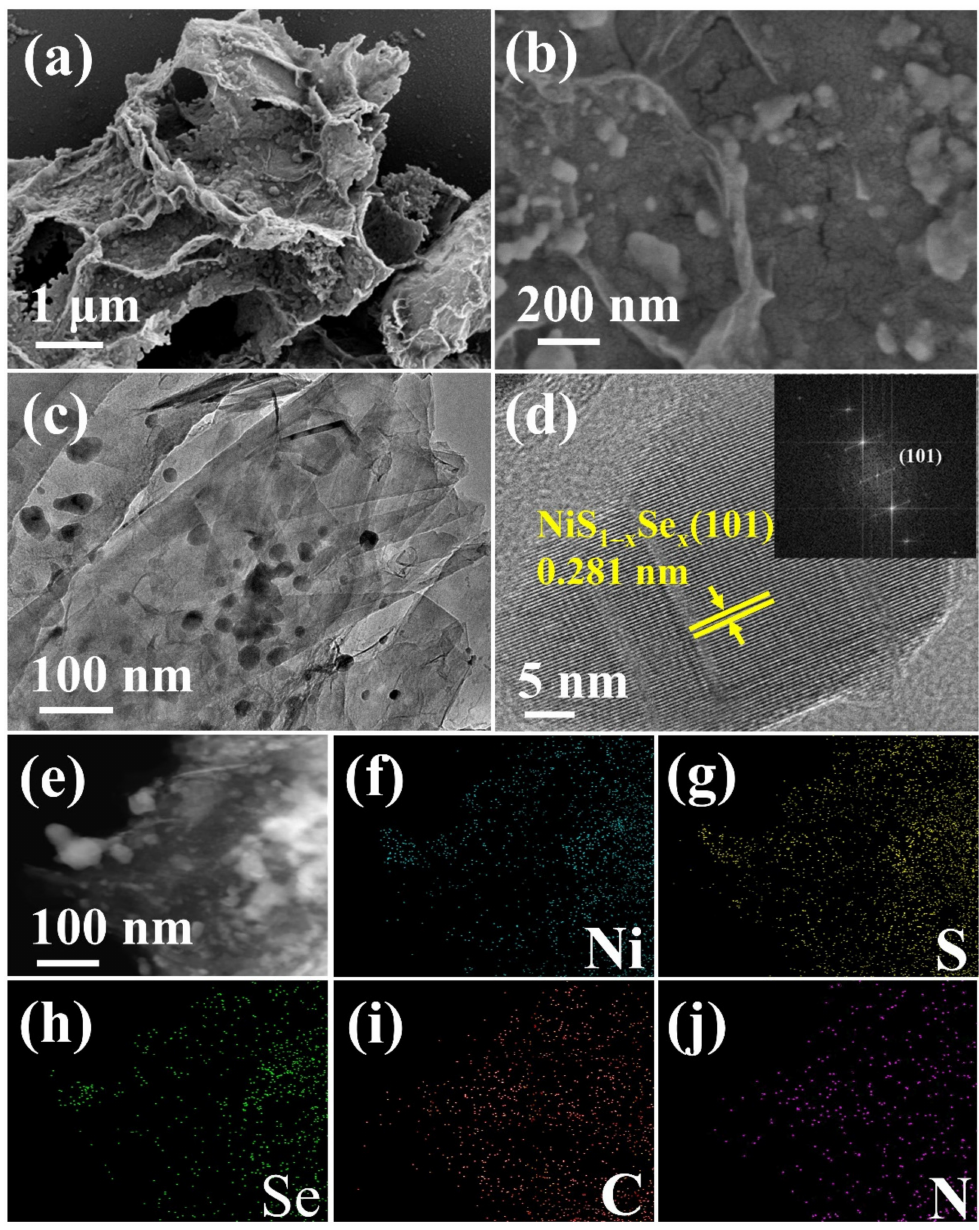
Figure 2. ( a , b ) FESEM, ( c ) TEM, ( d ) HRTEM and FFT pattern, and ( e – j ) elements mapping images of NiS 1 − x Se x @N–rGO